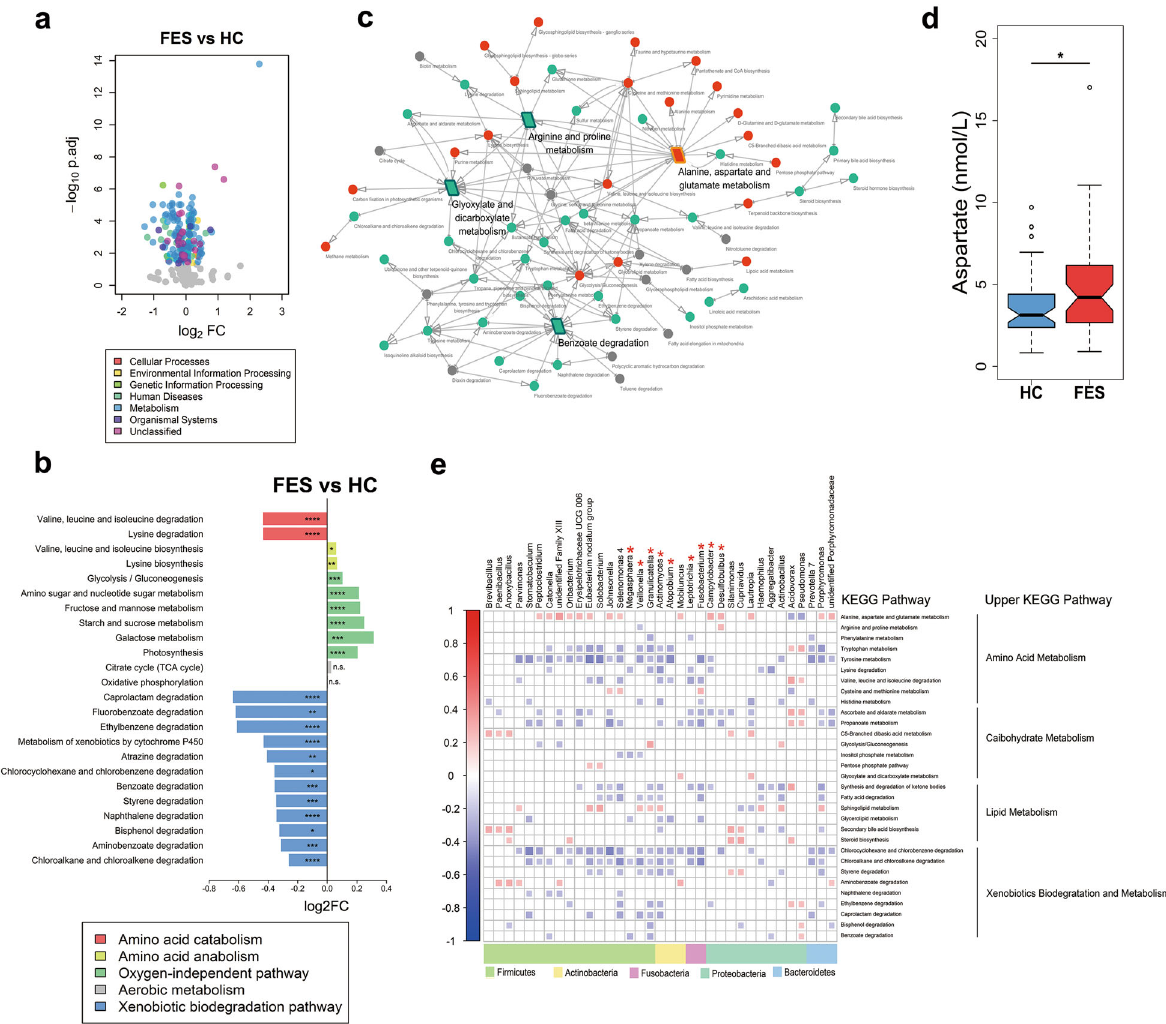
Fig. 4 The functions of the salivary microbiota were dysregulated in the FES and CHR groups, especially those of metabolism related pathways. a A volcano plot shows the differentially abundant KEGG pathways in FES versus HCs. b Selected metabolic pathways associated with amino acid catabolism and anabolism, oxygen-independent pathway and xenobiotic biodegradation pathway were differentially abundant in the FES group relative to HCs. False discovery rate adjusted q values were calculated based on p values estimated by DESeq2, adjusting for age, gender, and education level. * q < 0.05; ** q < 0.01; *** q < 0.001; **** q < 0.0001; n.s. indicates no signi fi cance. c Correlation network of KEGG pathways classi fi ed as the term metabolism based on their upstream/downstream relationships. Parallelograms indicate trigger pathways or main terminal pathways. Red dots/parallelograms represent pathways enriched in the FES group compared to HCs, while green represents depleted pathways, and gray denotes pathways with no signi fi cance. d Levels of plasma L -aspartate were increased in the FES group relative to HCs, controlling for confounders. Center lines of box plots show median values, box hinges indicate fi rst and third quartiles, and whisker represent the furthest data points within 1.5 interquartile ranges of the hinges. P values were calculated by quantile regression, adjusting for age, gender, and education level. * p < 0.05. e The heatmap shows correlations of the selected genera of interest with certain KEGG pathways. Only statistically signi fi cant correlations ( p < 0.05) are shown. Red asterisk indicates H 2 S-producing bacteria. KEGG Kyoto Encyclopedia of Gene and Genomes, FC fold